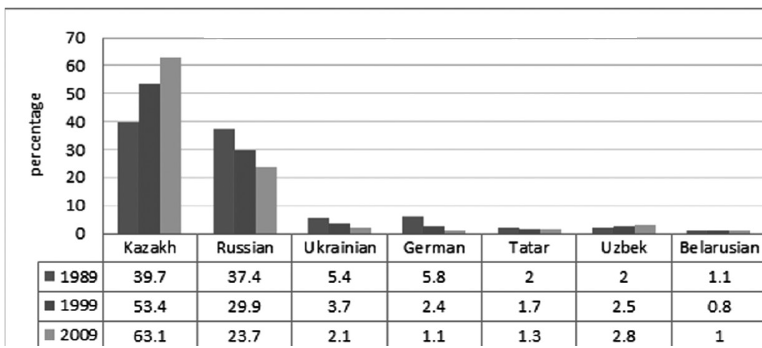
Figure 1. Ethnic component 2009